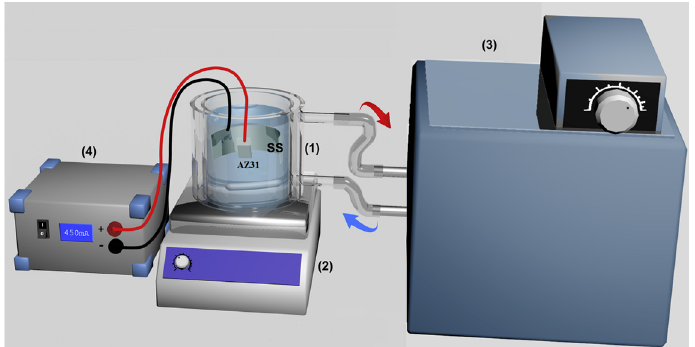
Figure 10. Experimental setup used for PEO: ( 1 ) electrolytic cell, ( 2 ) magnetic stirrer, ( 3 ) temperature-controlled water bath, ( 4 ) power supply.